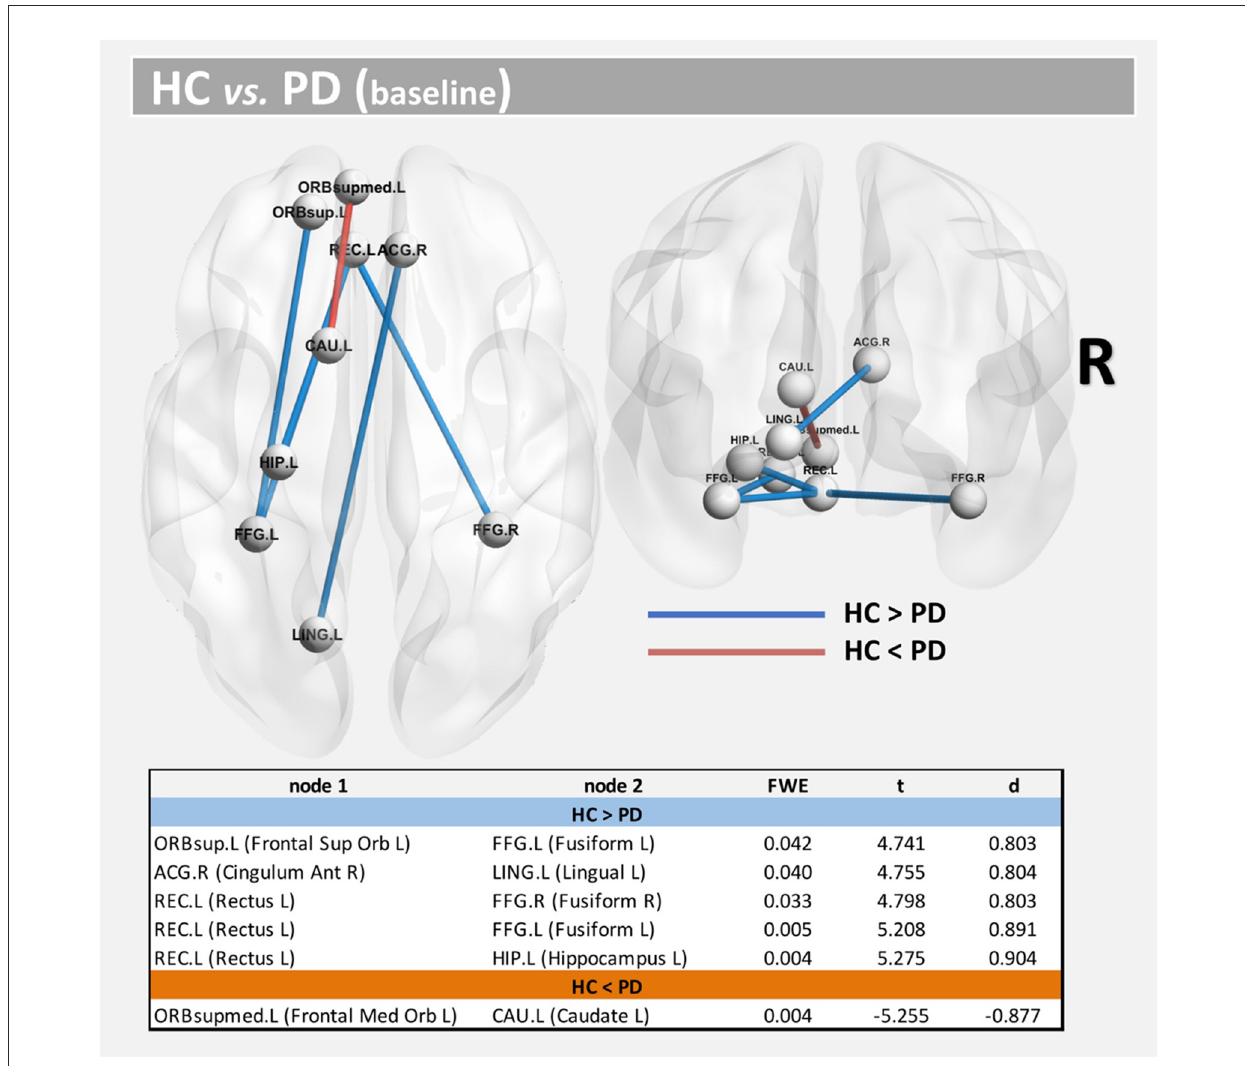
FIGURE1 Altered structural connectivity between HC and PD at baseline (cross-sectional analysis). Compared with HCs, PD showed lower connectivity across different nodes (Paths in blue color). However, higher connectivity in PD was also found between nodes CAU.L and ORBsupmed.L (Paths in red color). See also Table 2. For all significant paths we found FWE < 0.05 and large